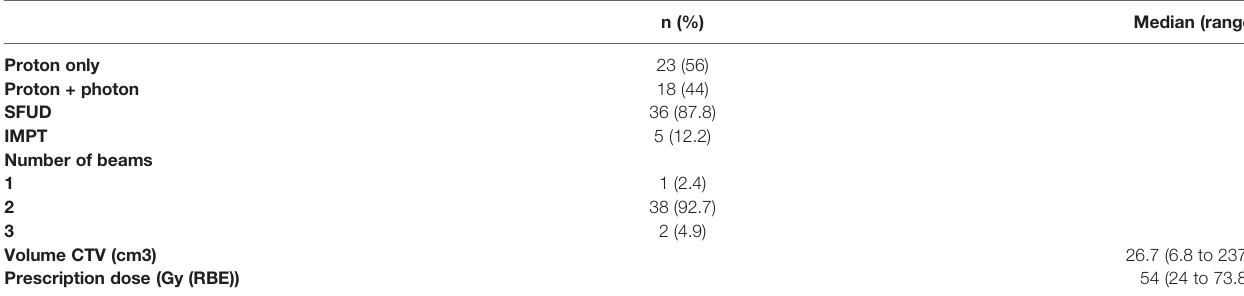
TABLE 2 | Characteristics of treatment for 41